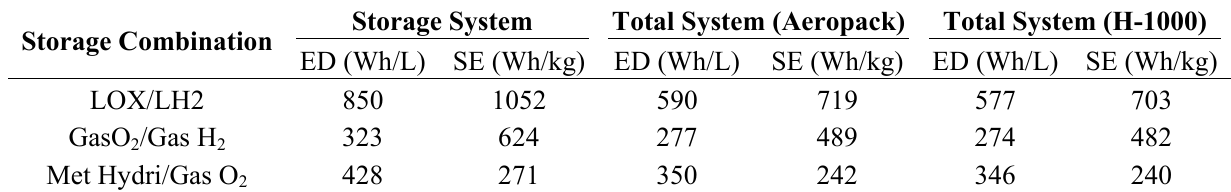
Table 6. Energy density and specific energy for storage and total